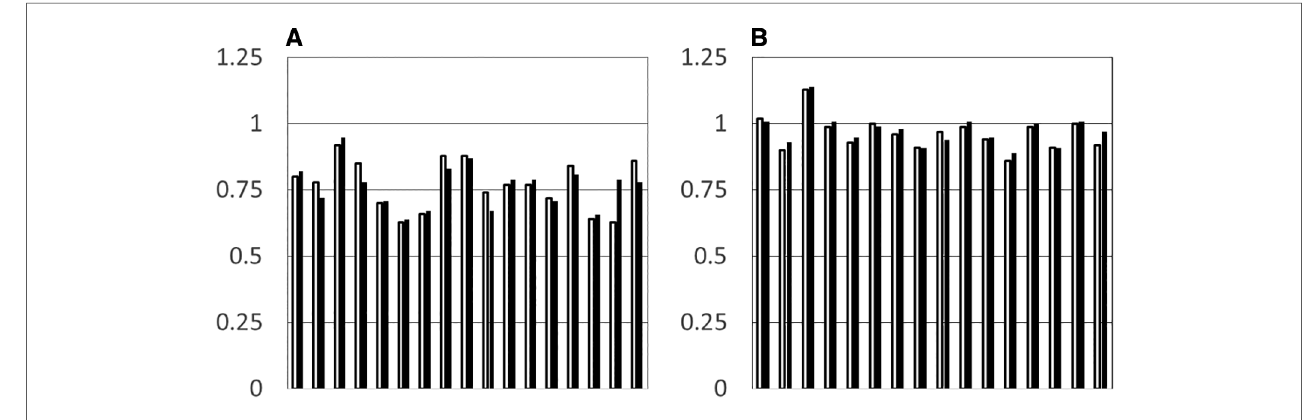
FIGURE 3 Median ratio of arm movement (non-dominant/dominant) at baseline (grey hars) and in the intervention period (black bars) for each individual participant. ( A ) Participants with UCP. ( B )